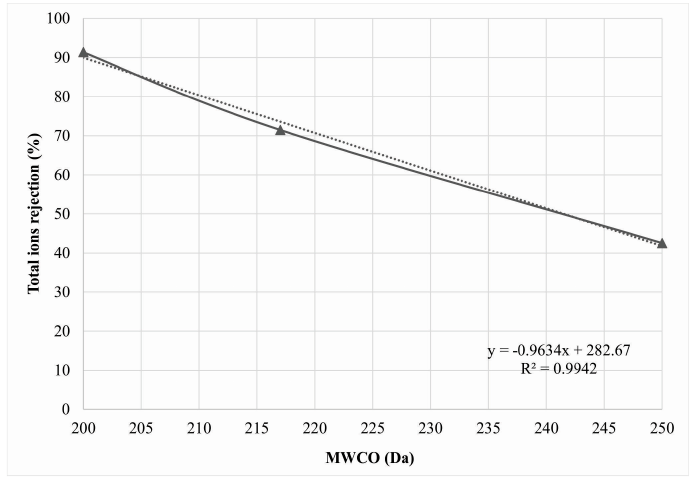
Figure 3. Influence of the different membrane molar cut-off properties to average total ion separa- tion efficiency.